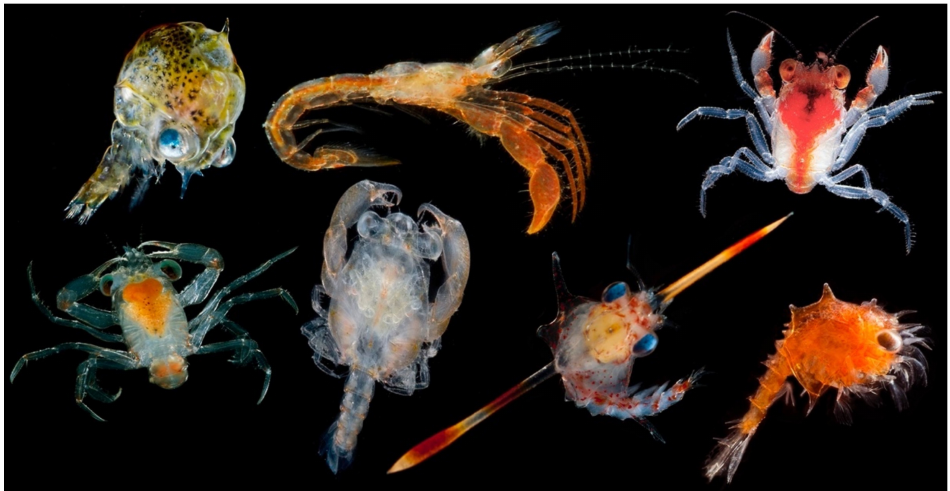
Figure 2. Examples of crab developmental stages collected on deep-pelagic research cruises in the northern Gulf of Mexico. ©Dant é Fenolio